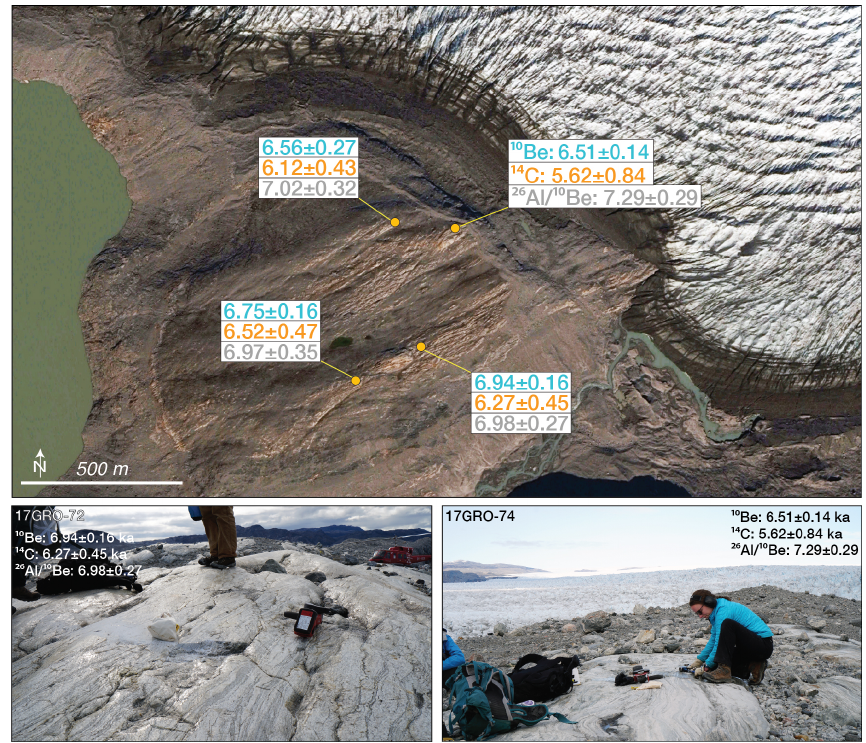
Figure 13. 10 Be ages, in situ 14 C ages (ka ± 1SD), and measured 26 Al / 10 Be ratios at each bedrock sample site on the southwestern side of KNS. Also shown are representative bedrock sample sites 17GRO-72 and 17GRO-74. Map data: © Google Maps, Maxar